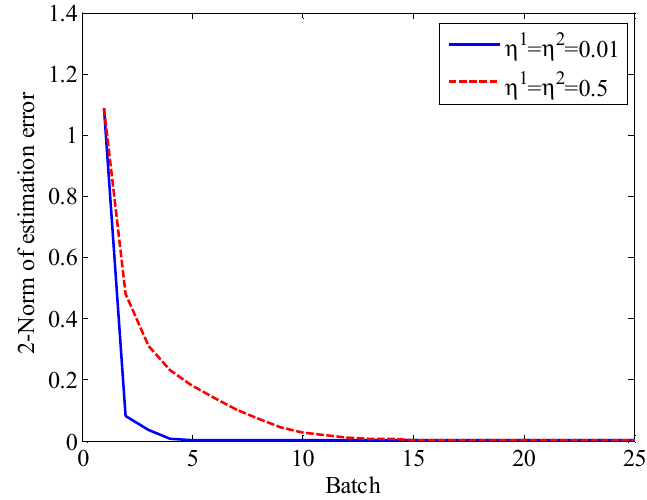
Figure 2. The convergences of the learning identification algorithm.